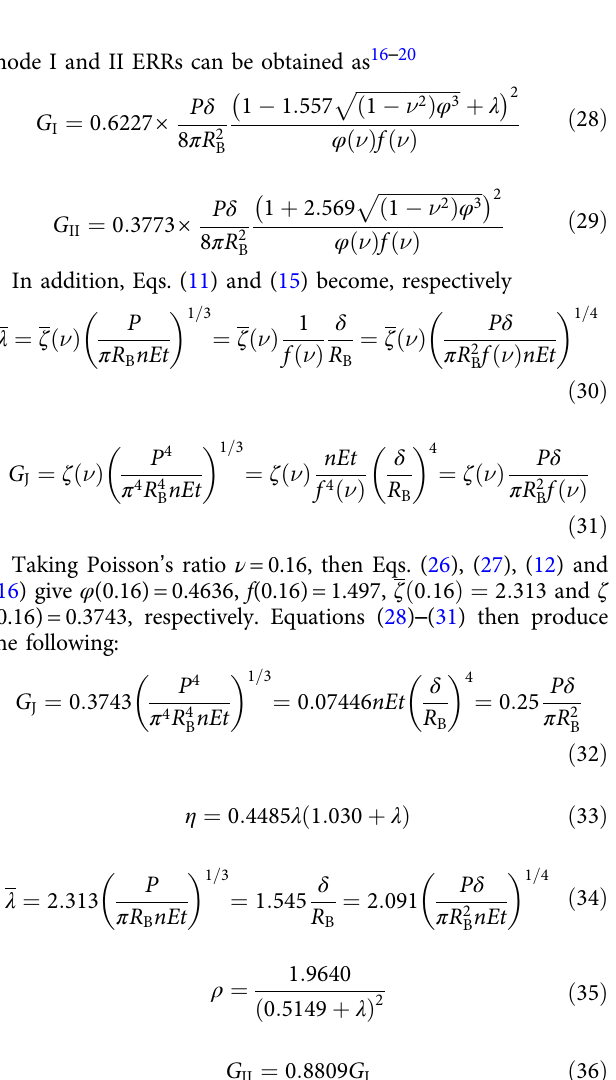
Fig. 3 Delaminating graphene fi lms under a point load. a Plot showing adhesion toughness G c vs. the fracture mode mixity ρ . b , c Plots showing the theoretical relationships between the point load P ( b ) and the blister radius R B ( c ) vs. the de fl ection at the centre of the blister δ . Note that the average measured value of δ / R B = 0.2309 for fi ve-layer graphene is